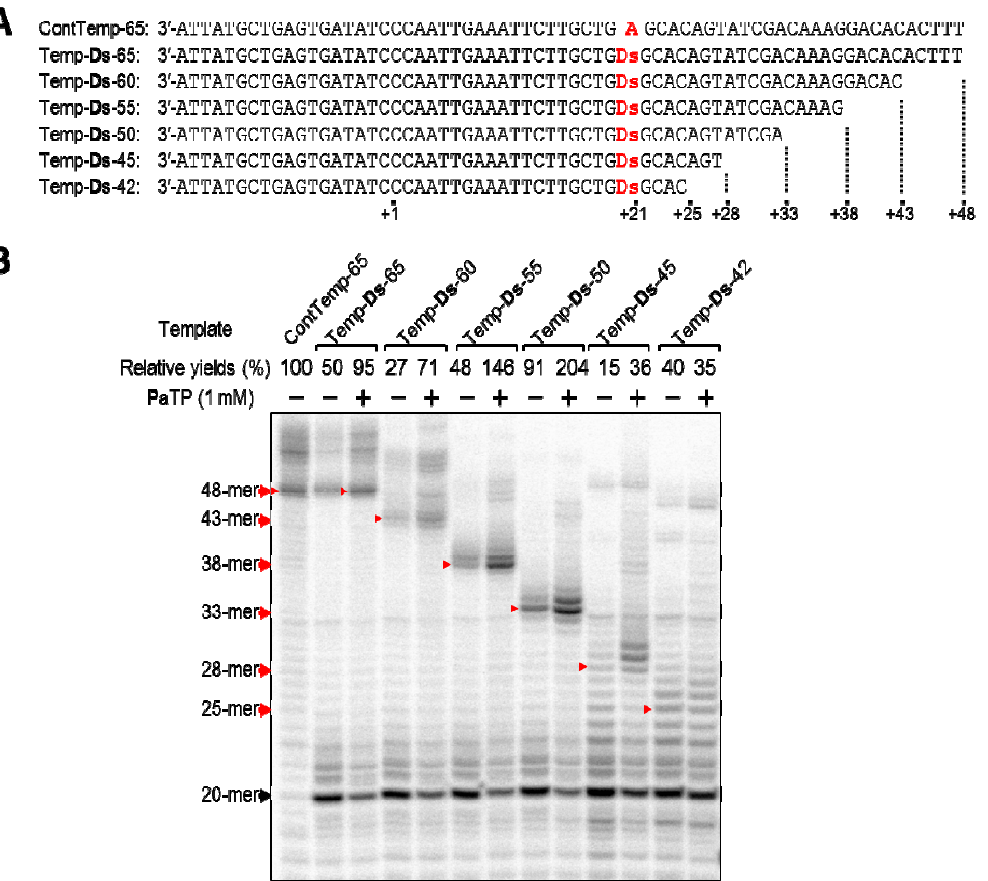
Figure 5. T7 transcription mediated by the Ds – Pa pair from DNA templates containing Ds , with different lengths after the unnatural base position. ( a ) Sequences of templates used in this study. (b) Gel electrophoresis of transcripts from different length templates with natural NTPs (1 mM) and in the presence or absence of Pa TP (1 mM). Transcripts were labeled at their 5 ′ -termini with [ γ - 32 P]GTP. The positions of the full-length products are indicated by red arrows. The relative yield of each full-length transcript was determined by comparison to the yield of the native transcript from the template consisting of the natural bases only. The experiments were independently repeated three times, and representative data are